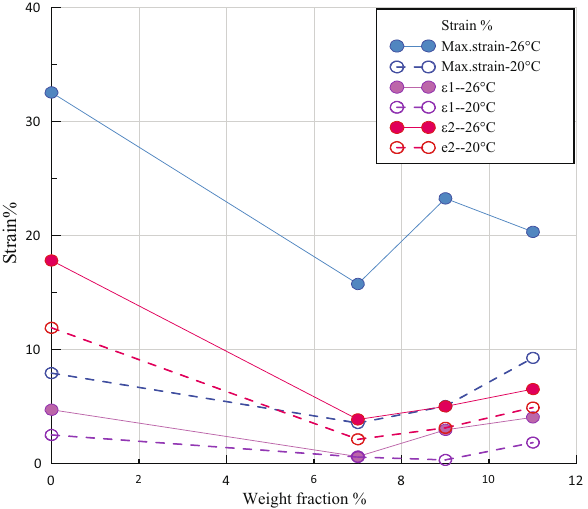
Figure 13: Comparison between 20 and 26°C of UP/PS creep beha - vior at di ff erent weight fractions.